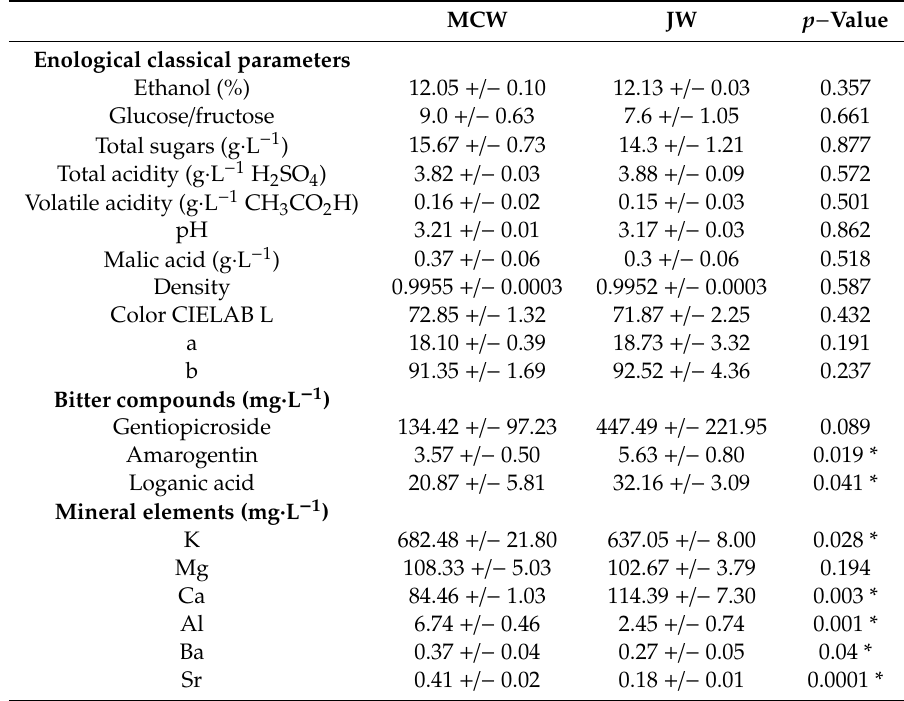
Table 2. Enological classical parameters and concentrations of main bitter compounds and mineral elements in gentian macerated wines from the two sampling